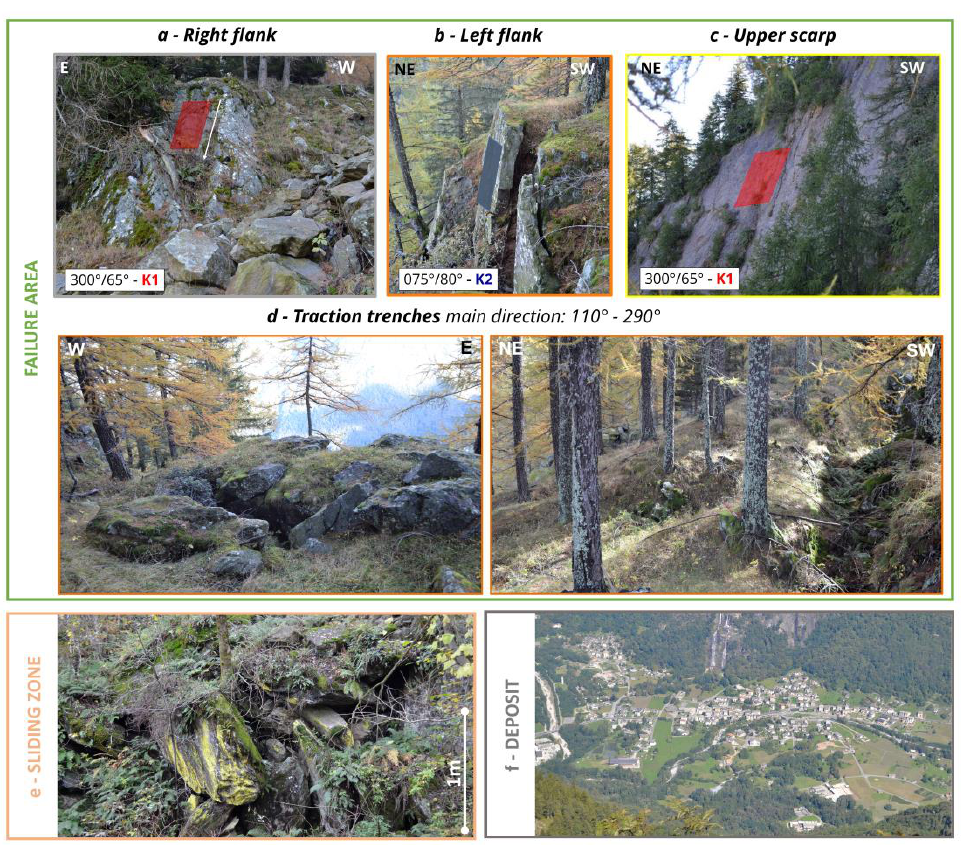
Figure 3. ( a – c ) Rock masses outcropping along the slope. Two main discontinuity sets are high- lighted with different colors — also plotted on the stereographic projection of Figure 2c (lower hemisphere); ( d ) Traction trenches outcropping at Alpe Prato del Conte locality; ( e ) Landslide deposit outcropping in the sliding zone along the slope; ( f ) Aerial view of the landslide deposit on which the new village of Piuro stands.